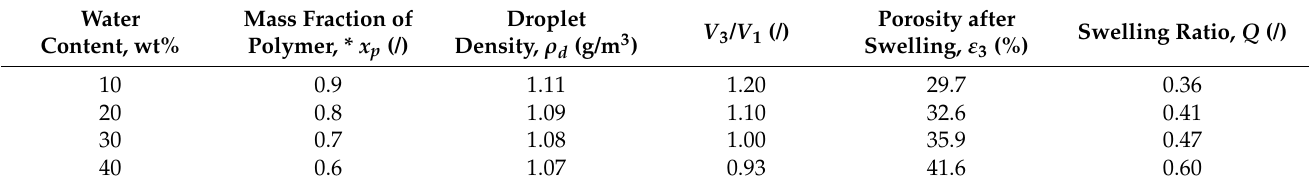
Table 2. The porosity of swollen particles and swelling ratios for different water contents in the PEGDA prepolymer solution. The volume ratios of swollen particles to the initial droplets are also provided, as well as the droplet densities.